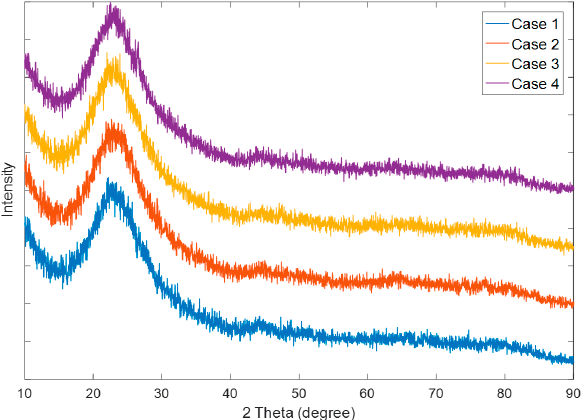
Figure 3. X-ray diffraction (XRD) patterns of the silica powders. Case 1: No added phenol-formaldehyde resin; Case 2: 0.027 g of added phenol-formaldehyde resin; Case 3: 0.030 g of added phenol-formaldehyde resin; Case 4: 0.033 g of added phenol-formaldehyde resin.